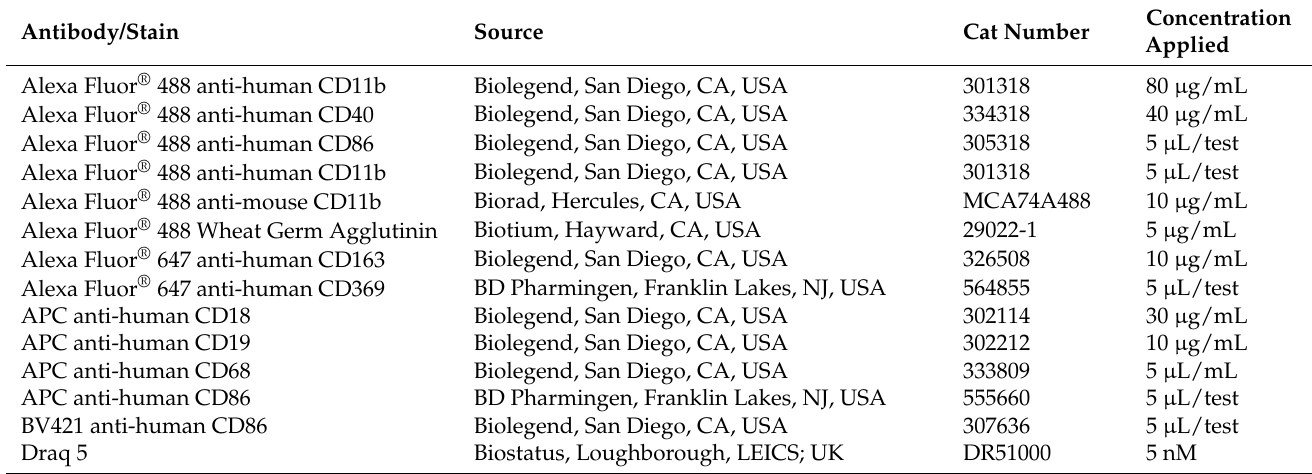
Table 1. Antibodies